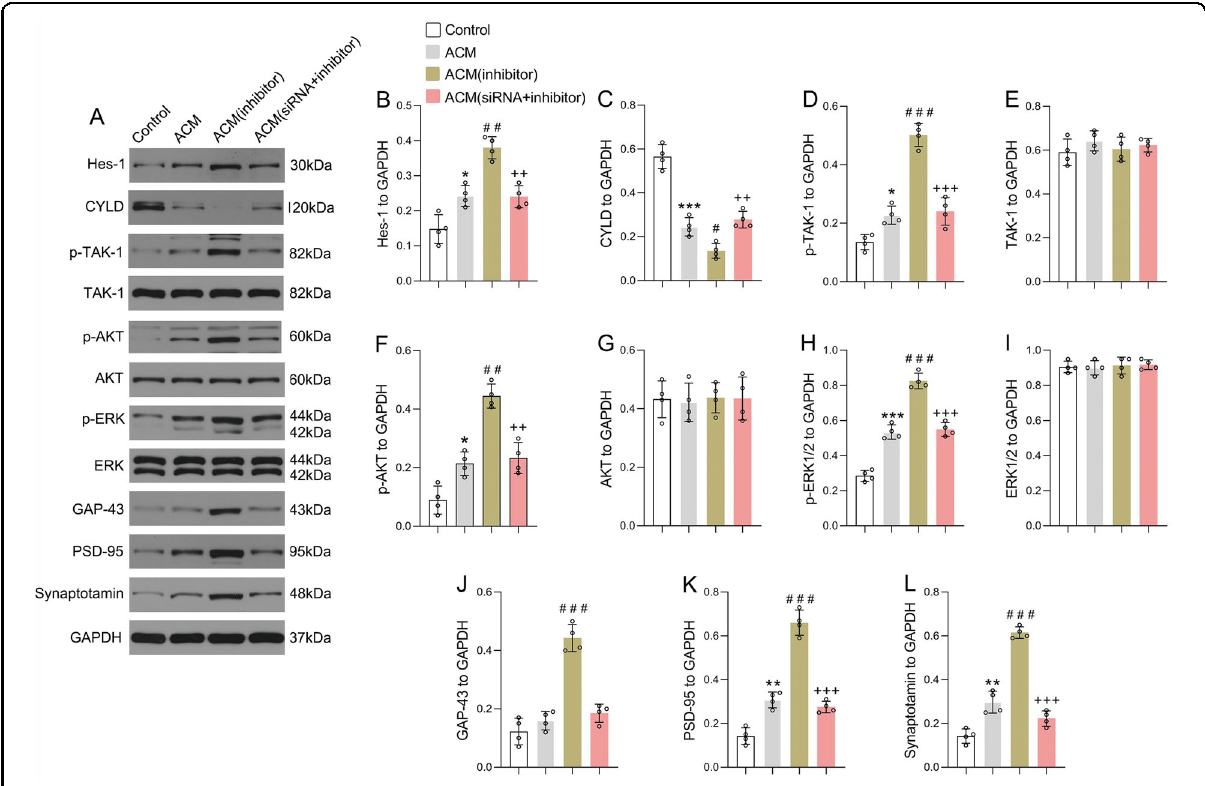
Fig. 6 Downregulation of miRNA-9-5p in astrocytes activated the Notch/CYLD/TAK1 pathway of neurons in the NVU in vitro. A The immunoblotting and quantitative data of B Hes-1, C CYLD, D p-TAK1, E TAK1, F p-AKT, G AKT, H p-ERK, I ERK, J GAP-43, K PSD-95, and L synaptotagmin in neurons ( n = 4/group) (* P < 0.05, ** P < 0.01, *** P < 0.001 versus the control group; # P < 0.05, ## P < 0.01, ### P < 0.001 versus the ACM group; ++ P < 0.01, +++ P < 0.001 versus the ACM (inhibitor) group) (ACM: astrocyte co-cultured model). Error bars indicate mean ±